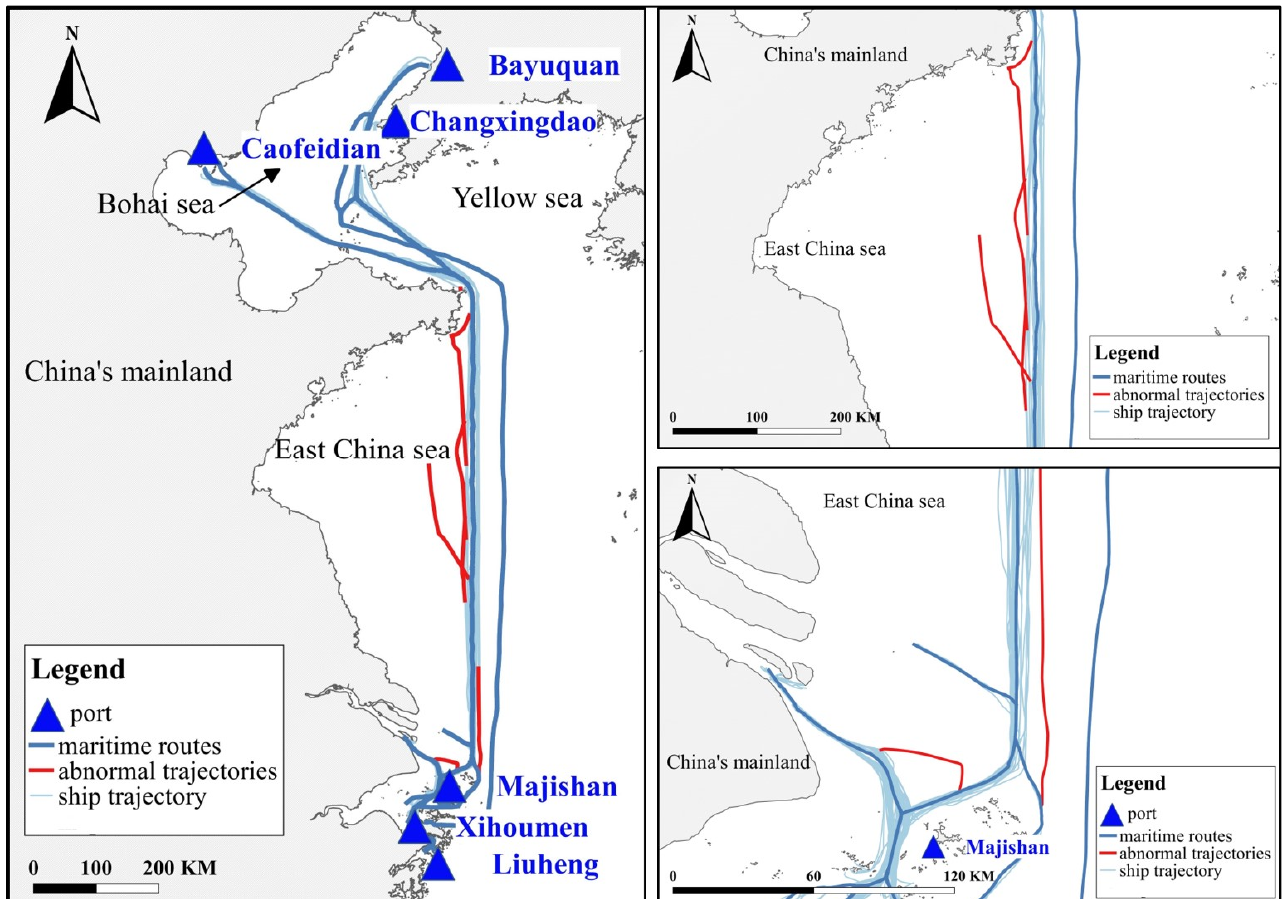
Figure 12. Abnormal ship behavior detection results based on spatial attributes.